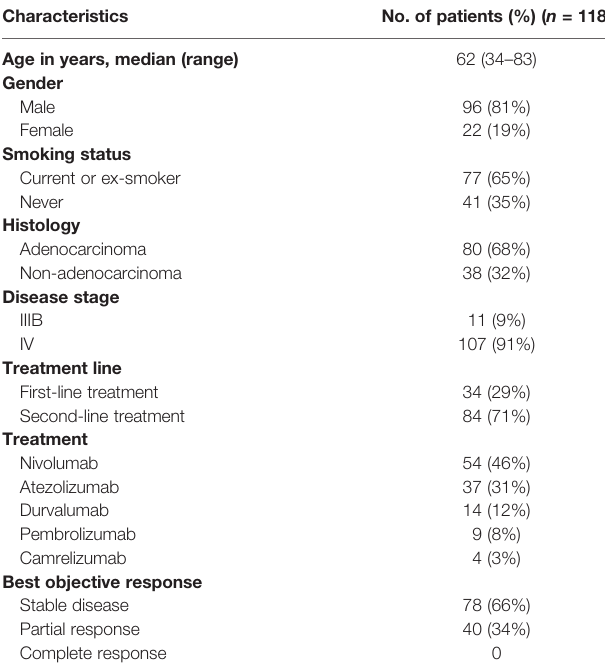
TABLE 1 | Characteristics of